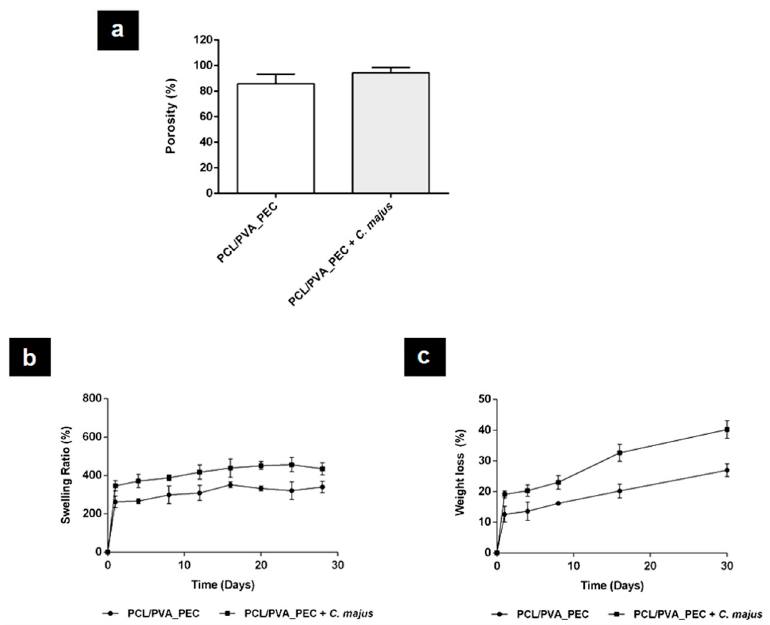
Figure 3. Characterization of the total porosity ( a ), swelling behavior ( b ), and biodegradation profile (weight loss) ( c ) of the produced electrospun nanofibrous meshes.